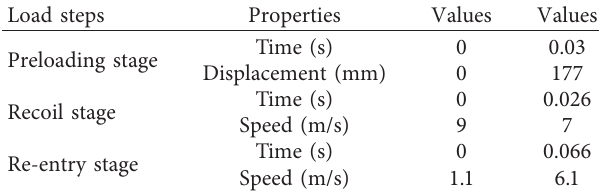
Figure 7: 3D assembly model of recoil spring, guide rod, and bolt carrier. Table 4: Load steps of different stages of recoil